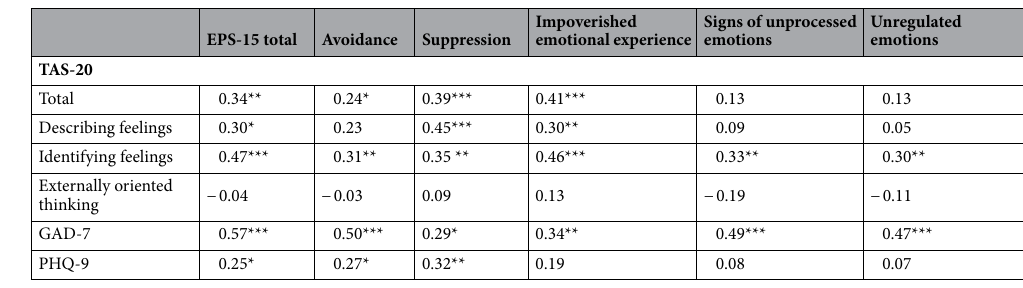
Table 5. Correlations between the 15-item Emotional Processing Scale (and subscales) with Alexithymia (TAS-20), anxiety (GAD-7), and depression (PHQ-9 (N = 74) 28 . * P < 0.05, ** P < 0.01, *** P <